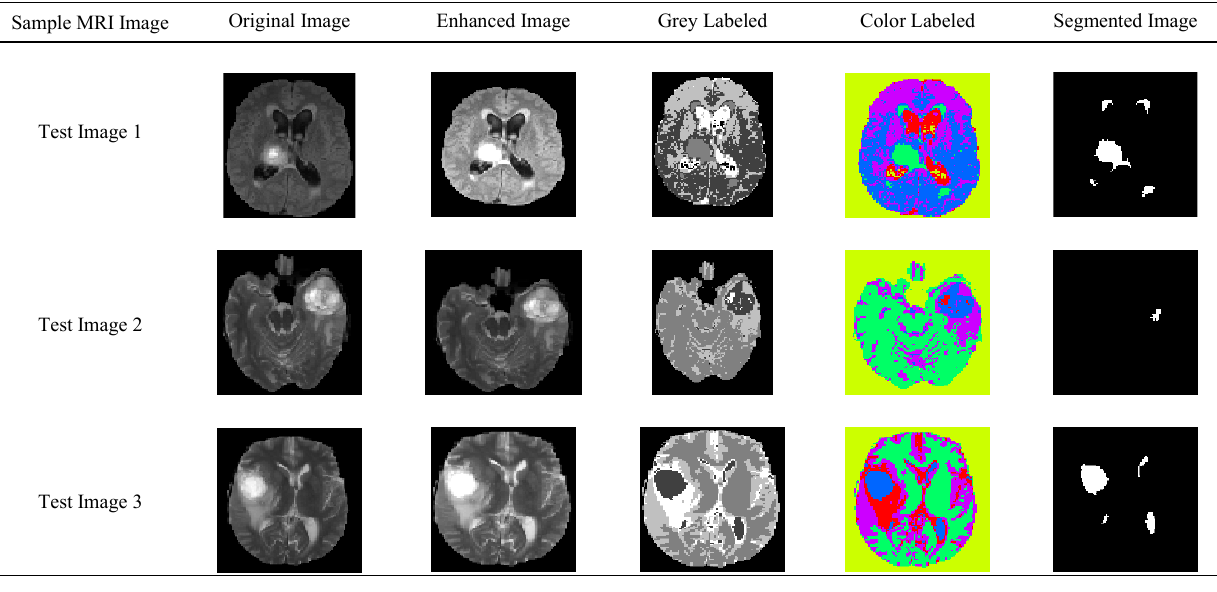
Table 2. Image Segmentation using k-means with